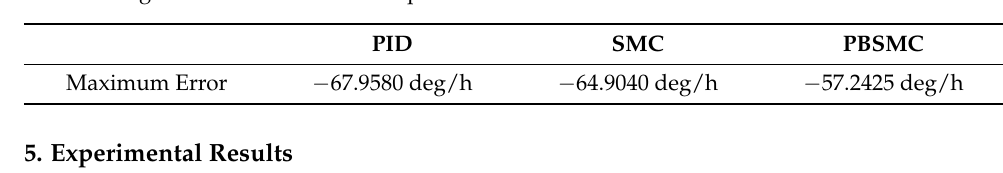
14 of 19 Table 7. Error Performance Comparison for Different Noise Levels.